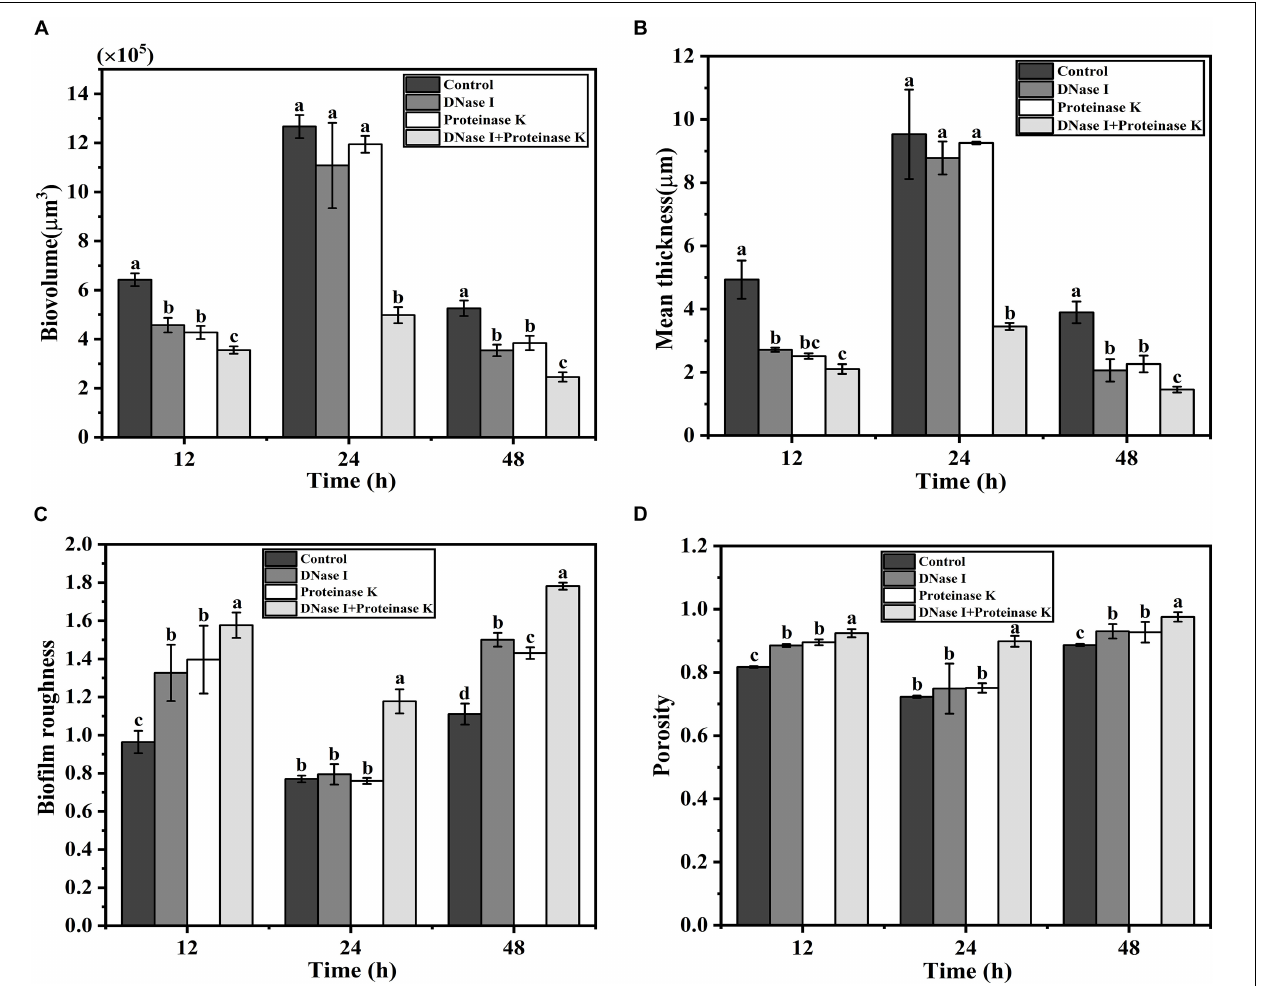
FIGURE 6 | Structural characteristics changes of V. parahaemolyticus biofilms treated with DNase I, proteinase K, and their combination at 12, 24, and 48 h of cultivation. (A) Biovolume, (B) mean thickness, (C) biofilm roughness, and (D) porosity. Error bars show standard deviations of three independent experiments, and the different letters represent significant differences among treatments ( P <